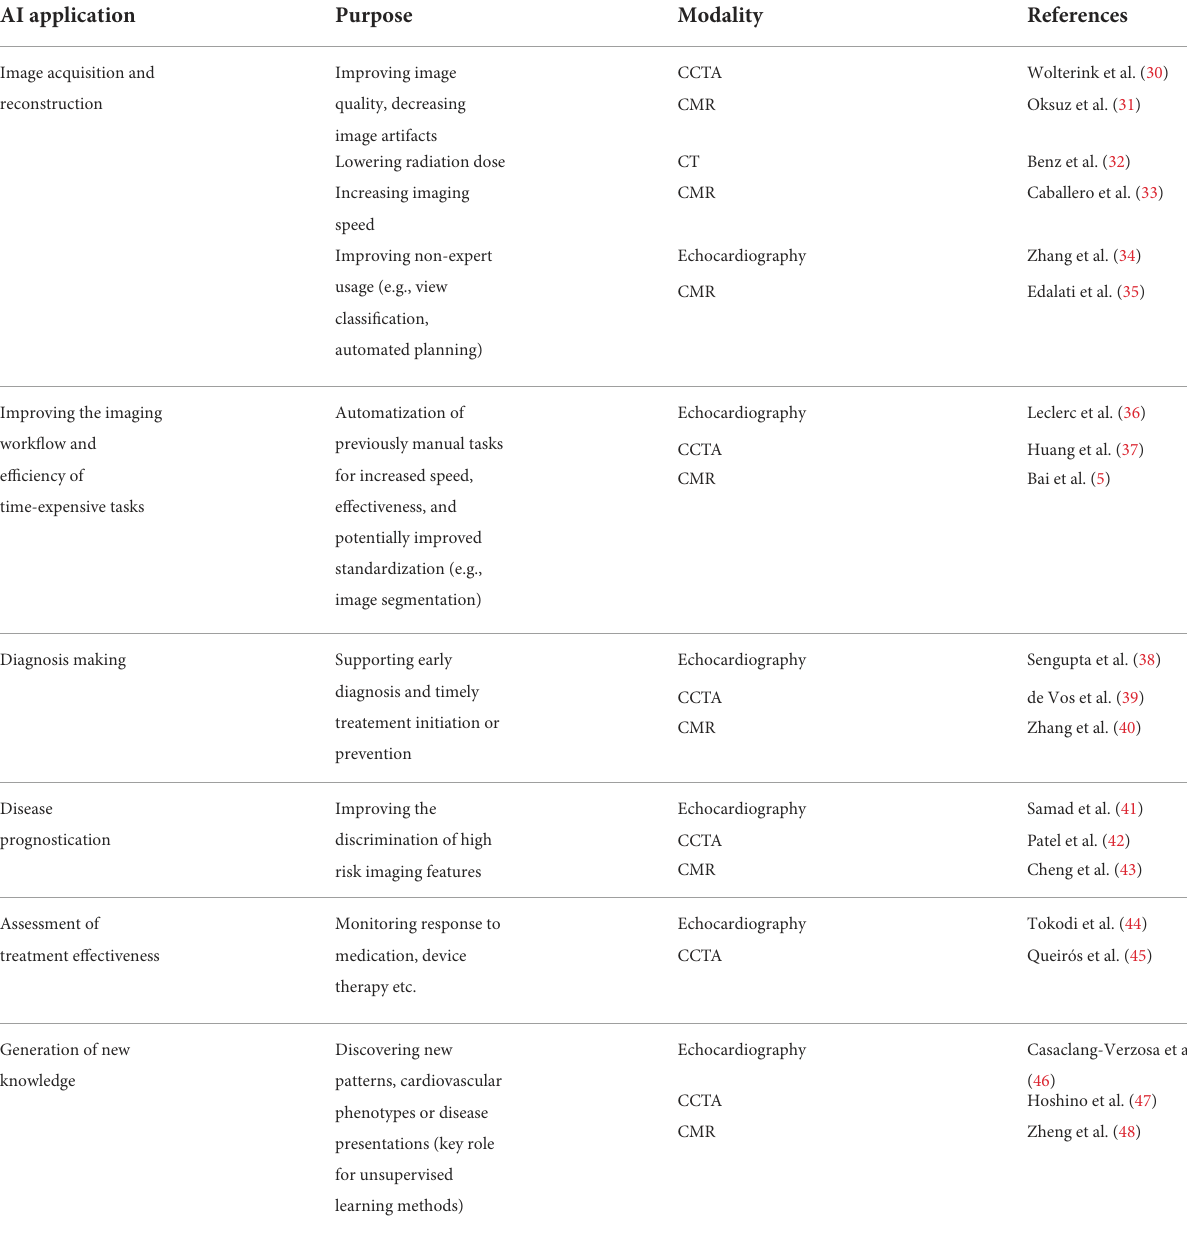
TABLE 1 Examples of AI applications from non-invasive cardiovascular